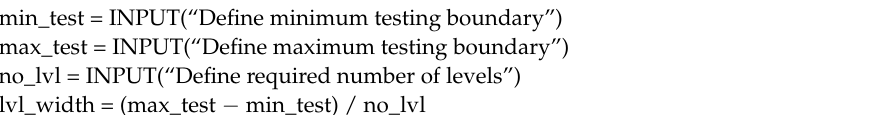
Algorithm 1. Algorithm for binning a given factor into desired number of factor levels in available data set according to desired testing boundaries.